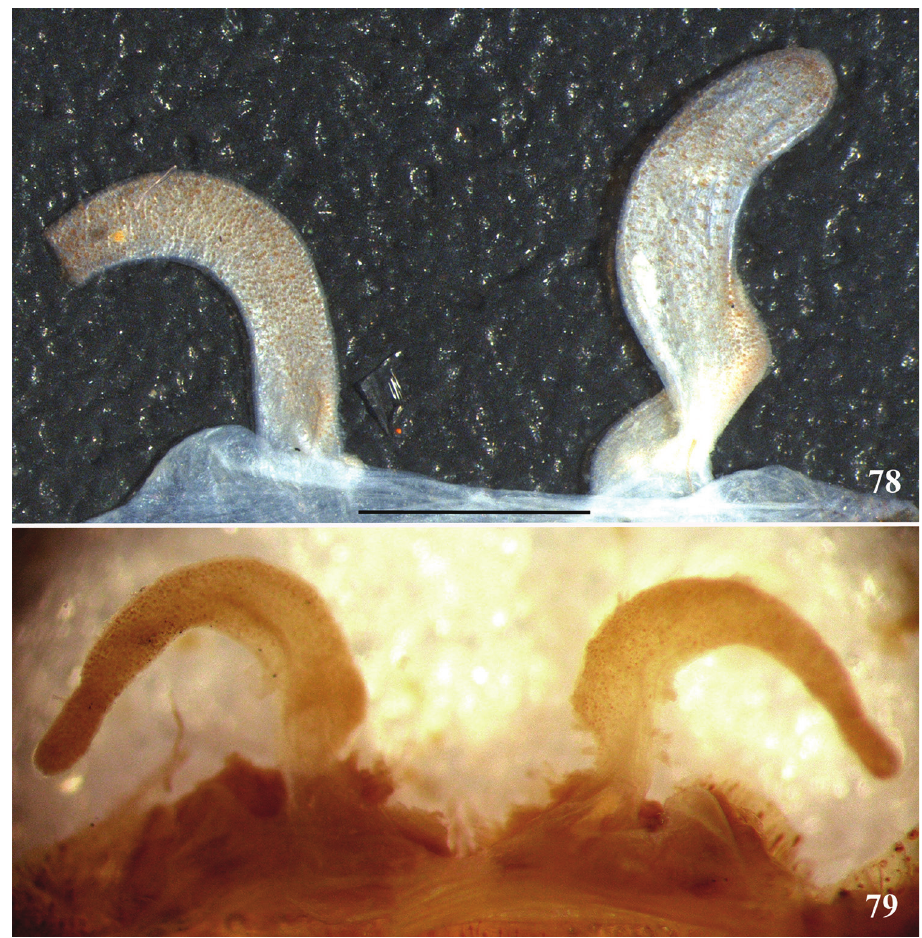
Figures 78–79. Avicularia minatrix Pocock, 1903, spermathecae variation. 78 Venezuela (IBSP 12886) 79 holotype, Duaca, state of Lara, Venezuela (BMNH 1903.7.1.120). Scale bars = 1 mm. Type II urticating setae: 0.38–0.51 long and 0.011–0.013 wide (measured in holo- type BMNH 1903.7.1.120). Spermathecae (Fig. 78): two completely separated, not-twisted long spermathecae, with walls lacking projections or lobes and accentuated outwards curvature medially. Midwidth as wide as its base width and weakly-sclerotized area shorter than half the length of well-sclerotized area. Color pattern (Fig. 88): carapace orange brown with golden short body setae with pink sheen. Carapace border with long setae the same color as dorsal carapace short body setae. Coxae, labium, sternum and maxillae orange brown, same color of ventral femora. Legs and palps with brown short body setae with pink sheen and long orange guard-setae. Leg rings on distal femora, tibiae and metatarsi whitish.